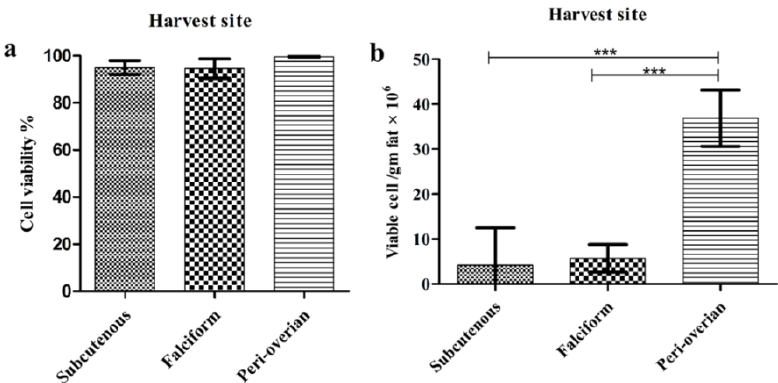
Figure 1. The effect of harvesting site on stromal vascular fraction (SVF) cell viability and quantity. ( a ) Viability percentage of the SVF cells from different harvesting sites. SVF cells isolated from per-ovarian adipose tissue (AT) showed the highest viability percentage; ( b ) Number of viable cells per gram fat from different harvesting sites. SVF cells isolated from the per-ovarian AT showed the highest number of viable cells per gram fat at *** p < 0.001. Data are expressed as the mean ± standard deviation ( n = 10). Statistical significance was tested using one-way ANOVA followed by Tukey’s post hoc test for multi-group comparisons. *** p < 0.001.